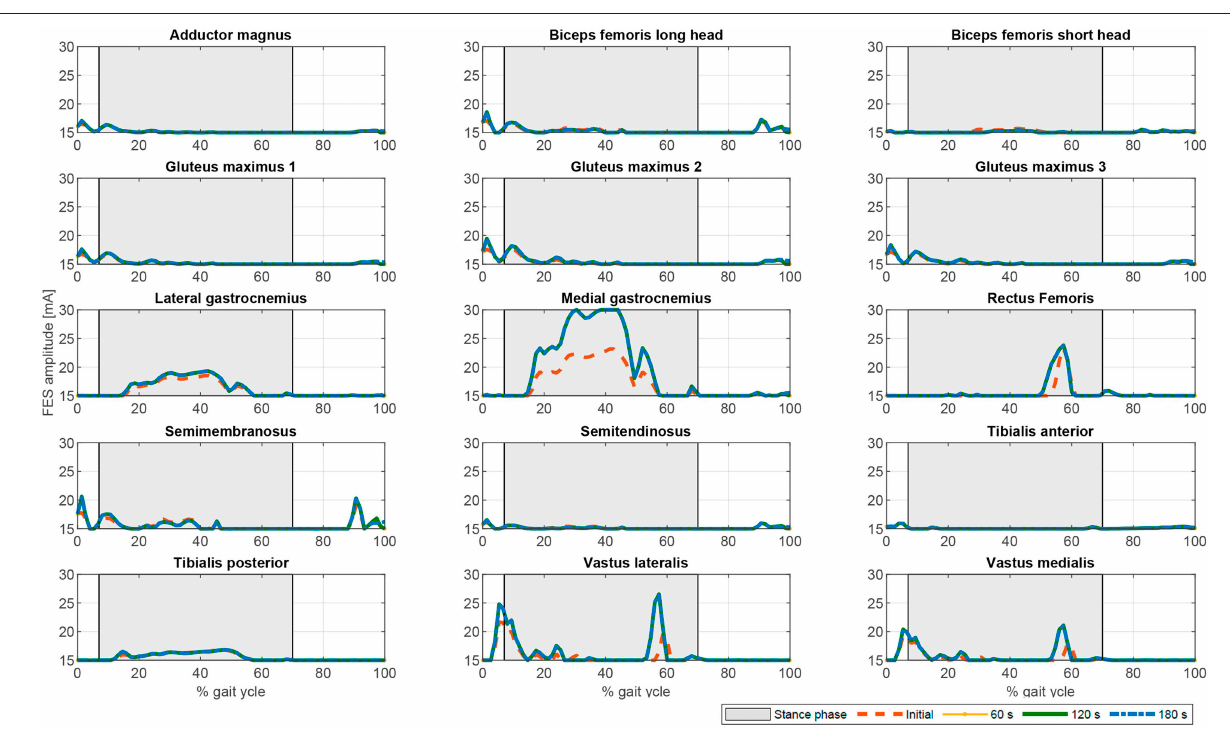
Frontiers in Neurorobotics |